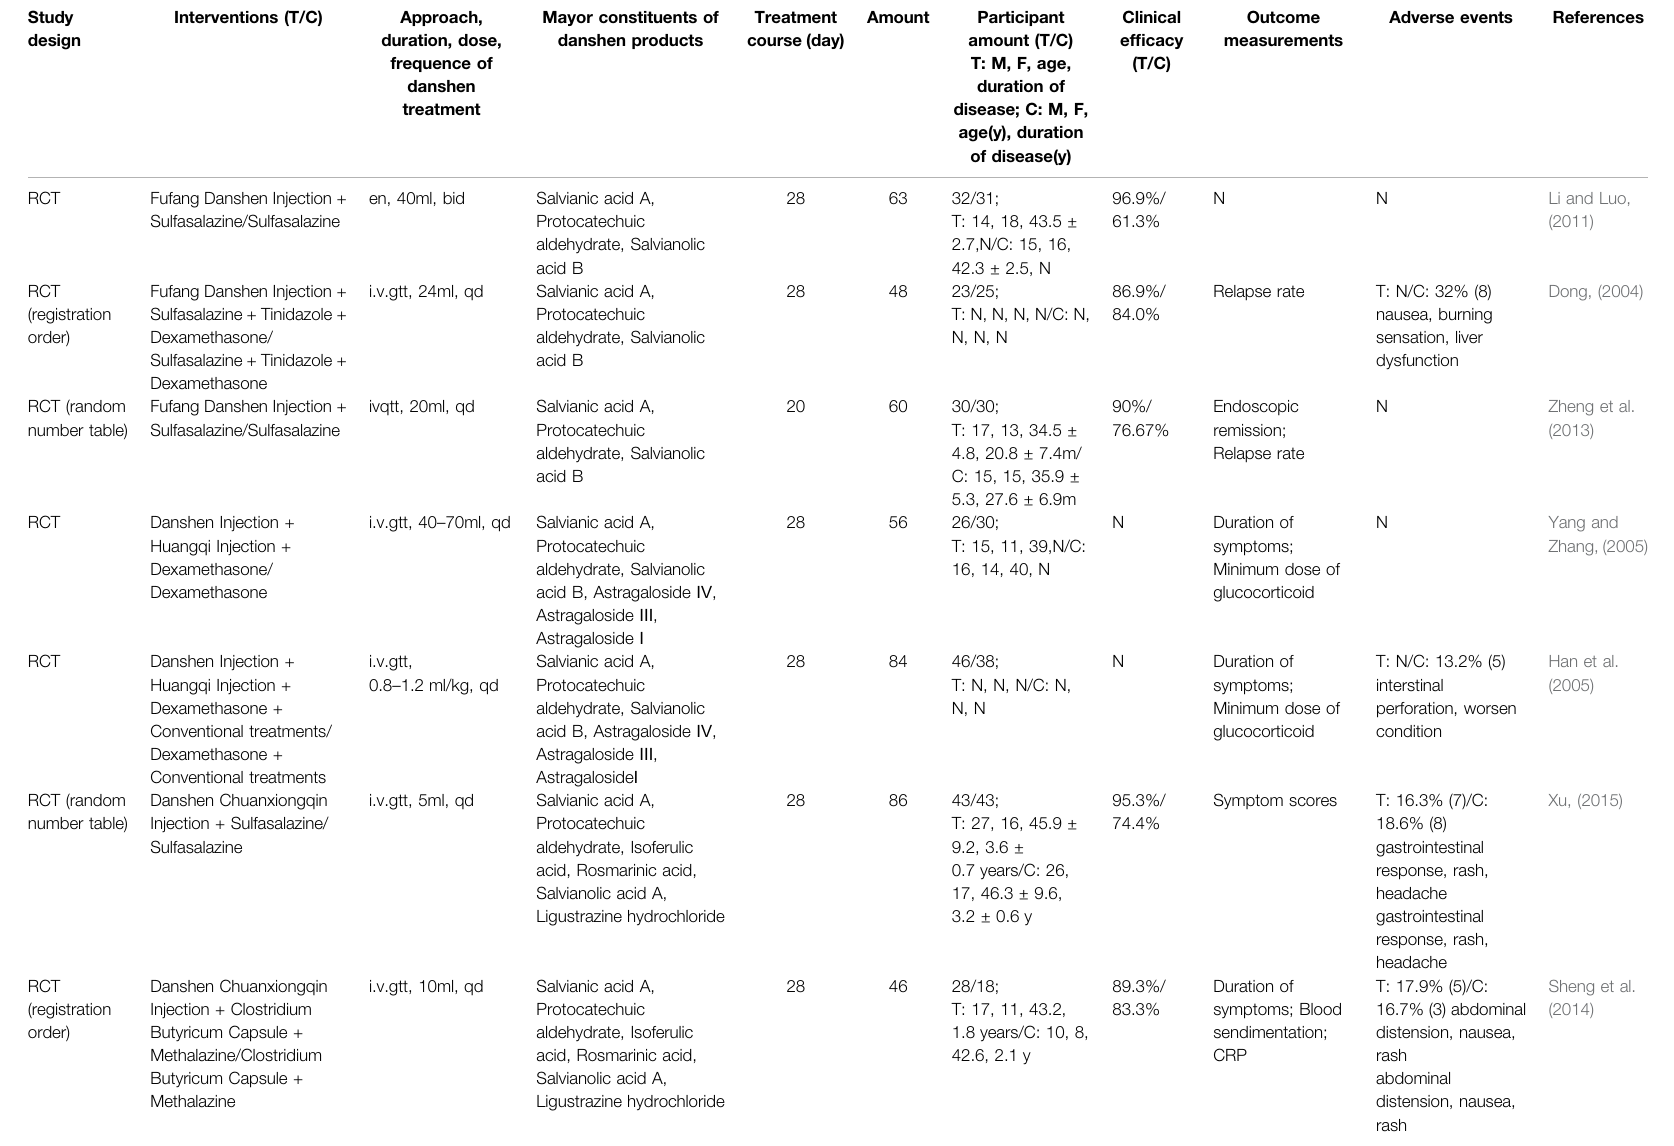
TABLE 5 | Clinical trials of Danshen products combined with other Chinese herbal products as supplementary interference in the regulation of ulcerative colitis (UC). Study